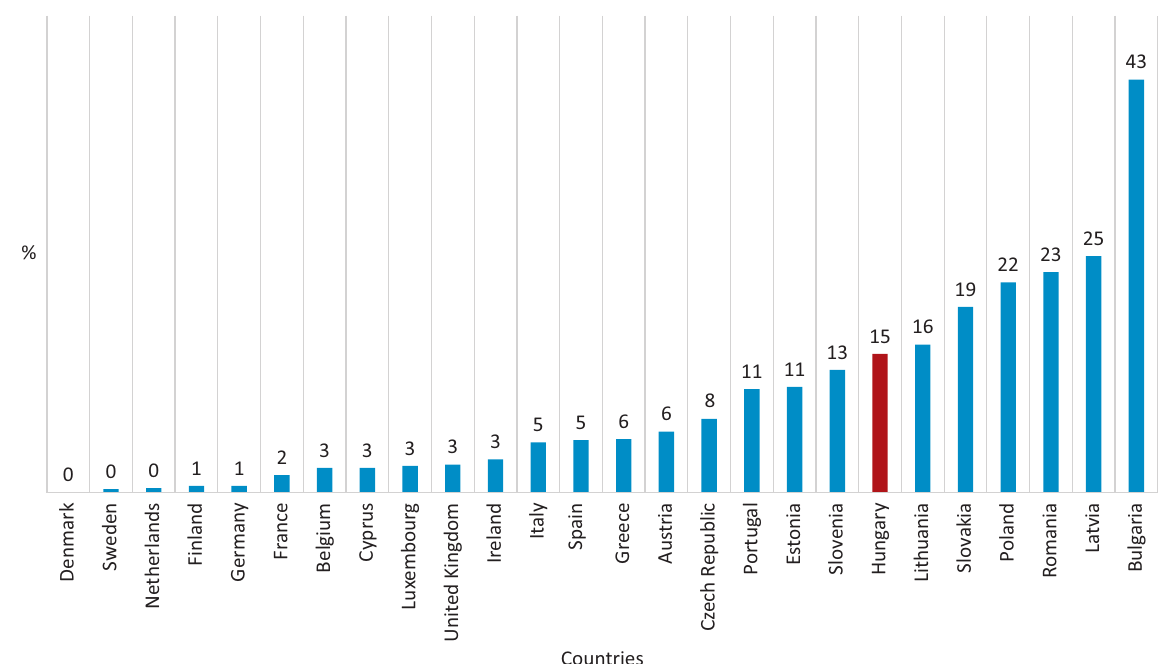
Figure 1. Share of children under the age of 18 living in a TGH, 2008 (in percentages). Source: Iacovou and Skew (2011). people who are limited in their daily activities (Burgess & Muir,